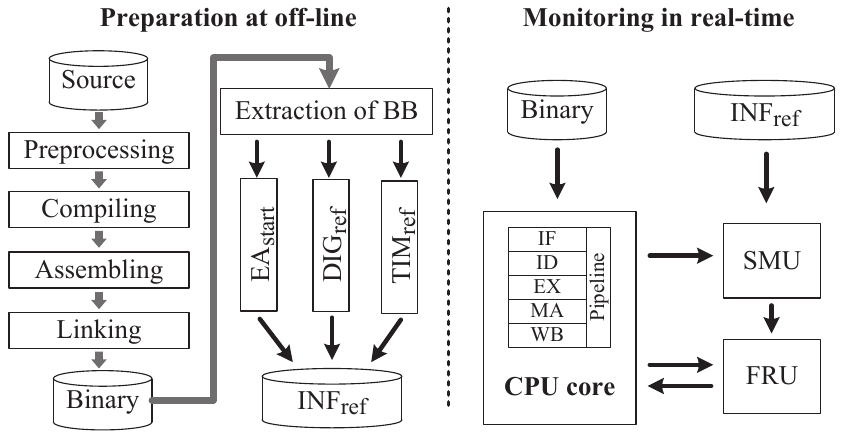
Figure 2. The extraction process of BB reference